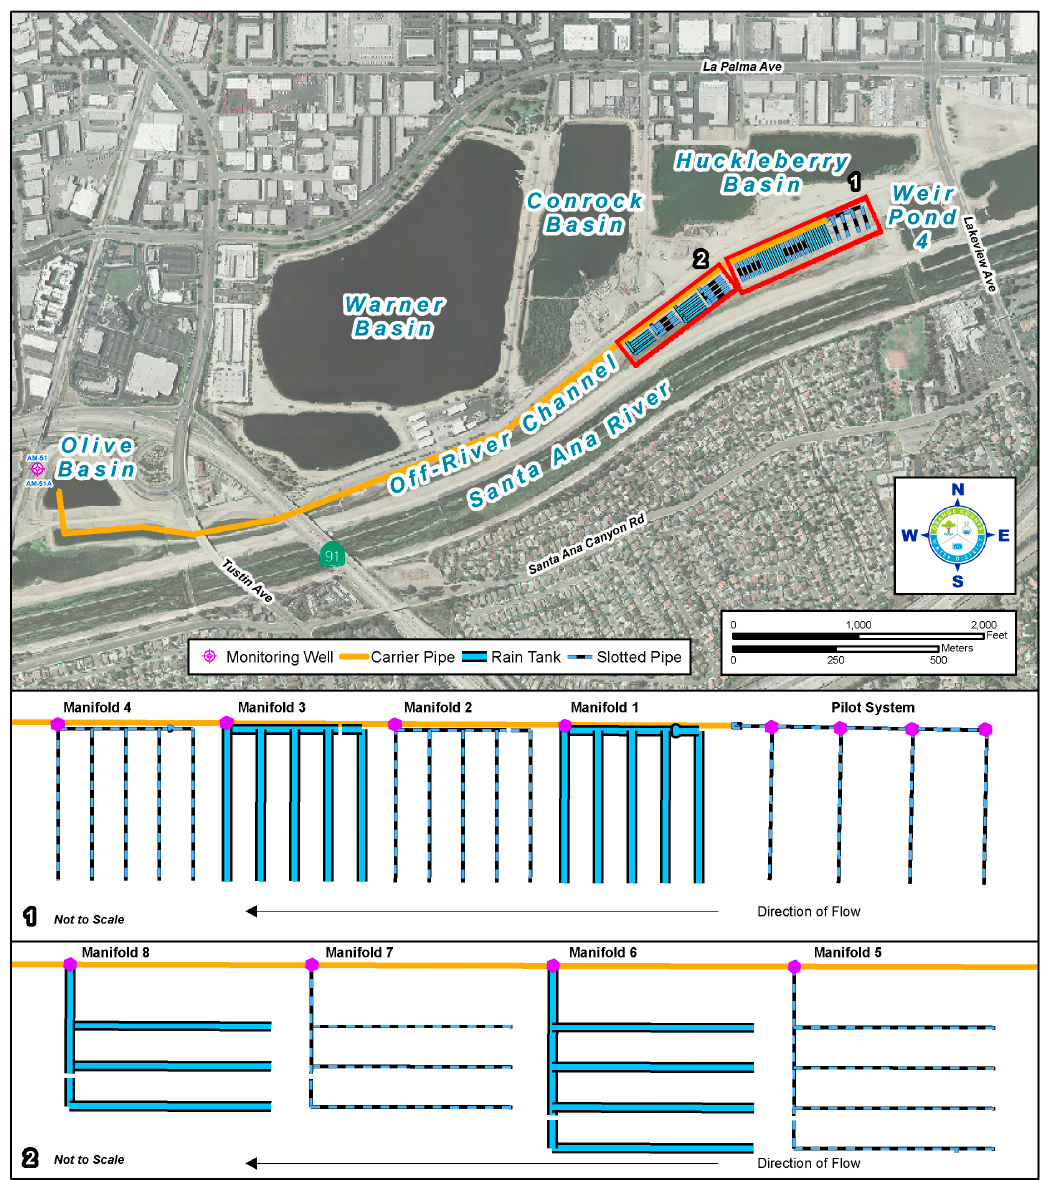
Figure 2. Location and Layout of the Riverbed Filtration System (RFS).